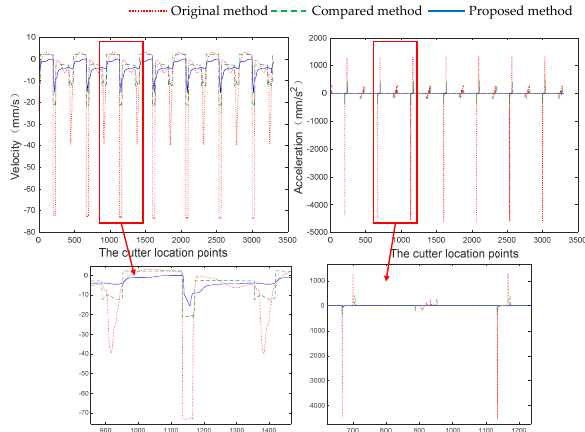
Figure 16. Comparison of motion state of the rotary axis.